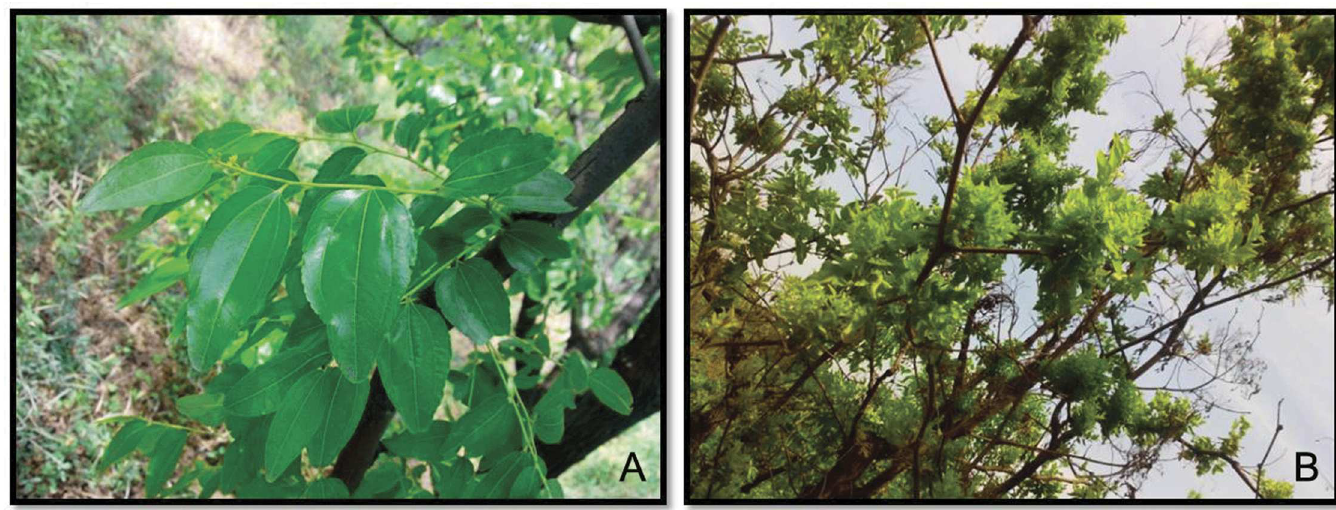
Fig 1. The Ziziphus jujuba wild type (ZZN) and the infected plant (ZZD) with witches broom disease in the field. A. ZZN; B. ZZD.